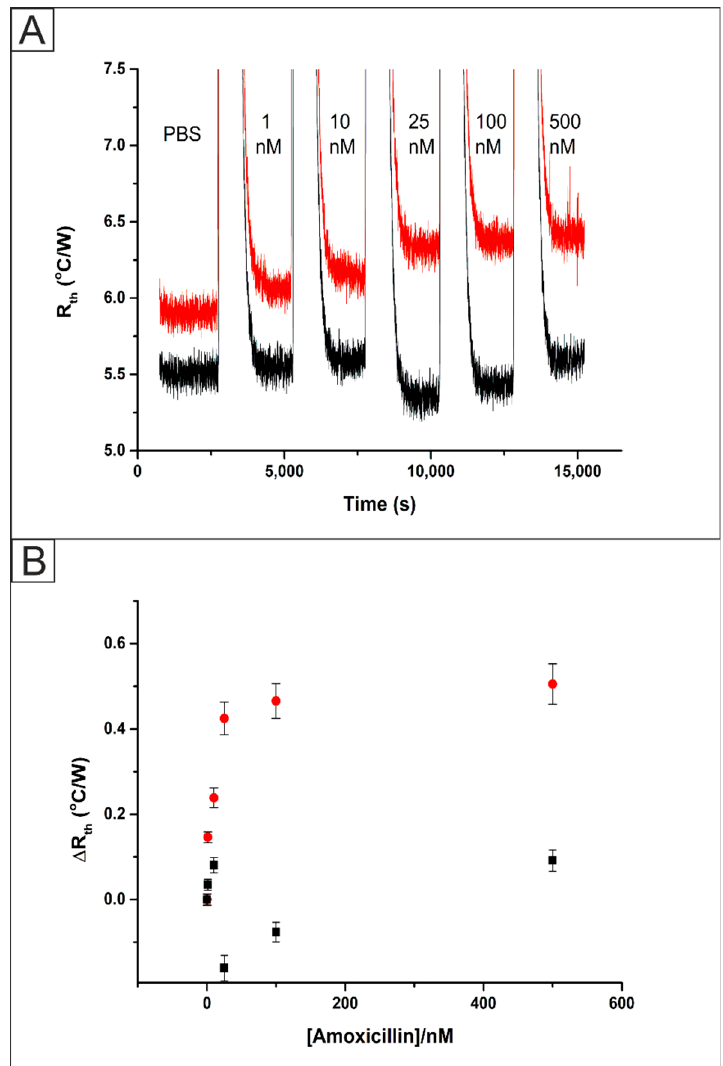
Figure 4. ( A ) The raw Heat-Transfer Method (HTM) data plot of R th versus time for the addition of amoxicillin (1–500 nM) in PBS to an Screen Printed Electrodes (SPE) functionalised with bulk UV polymerized MIP (red) and NIP (black). ( B ) Comparison between the absolute R th values obtained